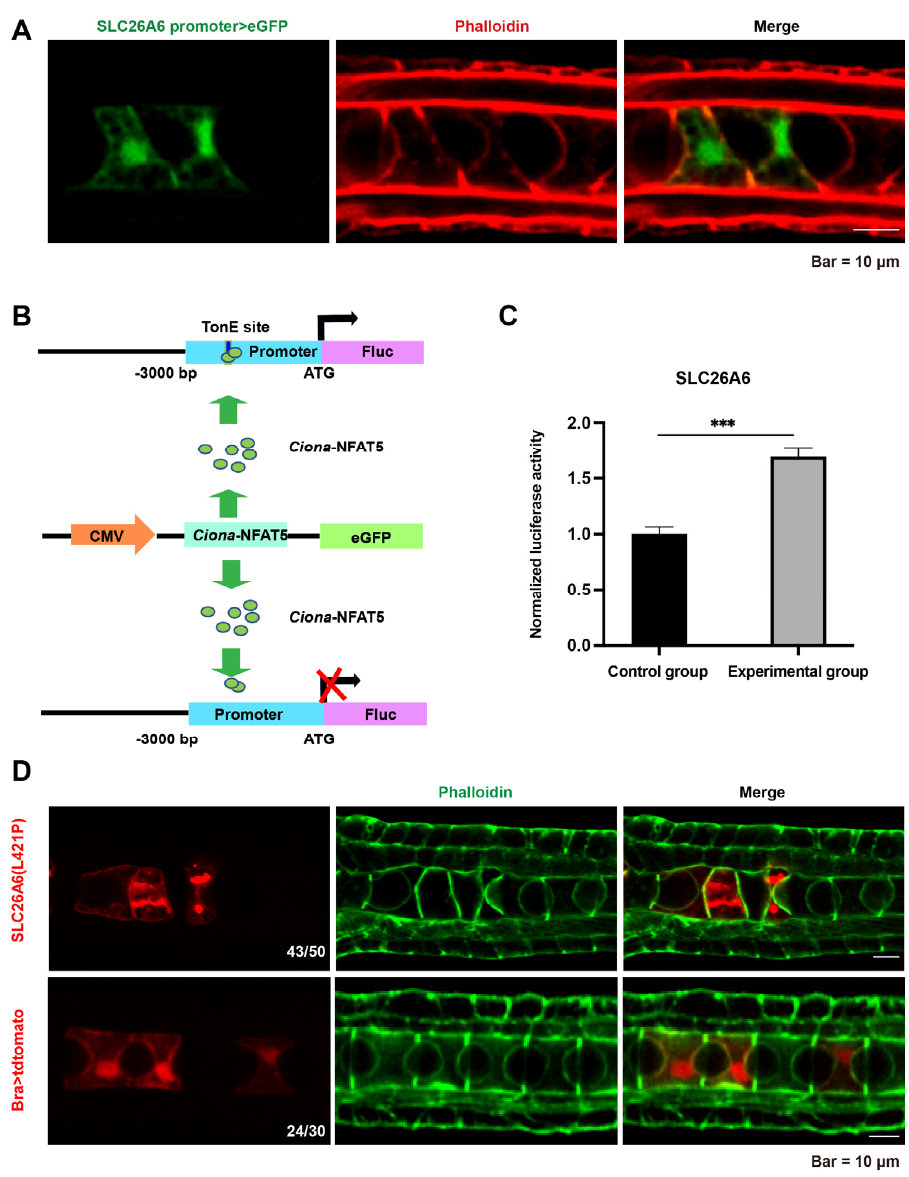
Figure 4. Ciona - NFAT5 regulates notochord lumen expansion via SLC26A6 . ( A ) The tissue